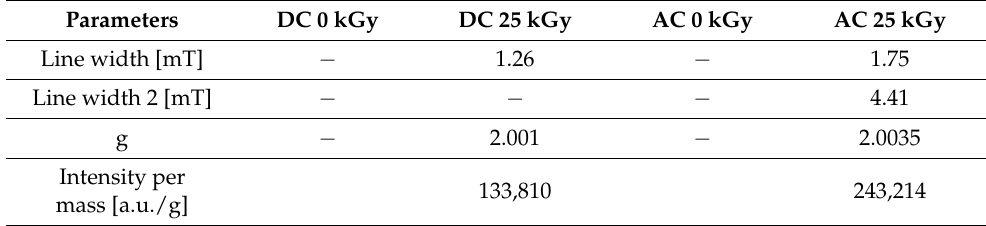
Figure 3. Optical microscope photographs of test compounds before and after irradiation. Table 2. Low range EPR spectra